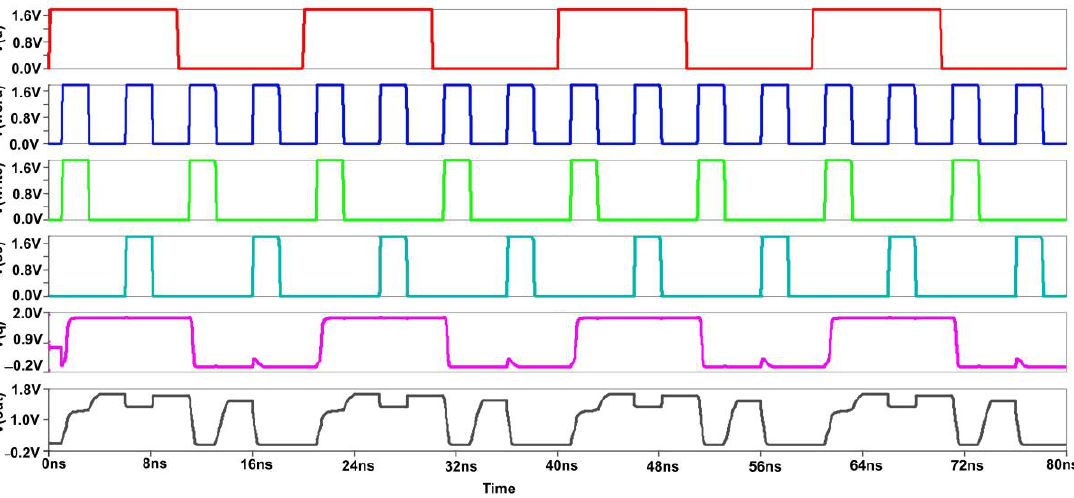
Figure 19. Output Waveform of Proposed Sense Amplifier.